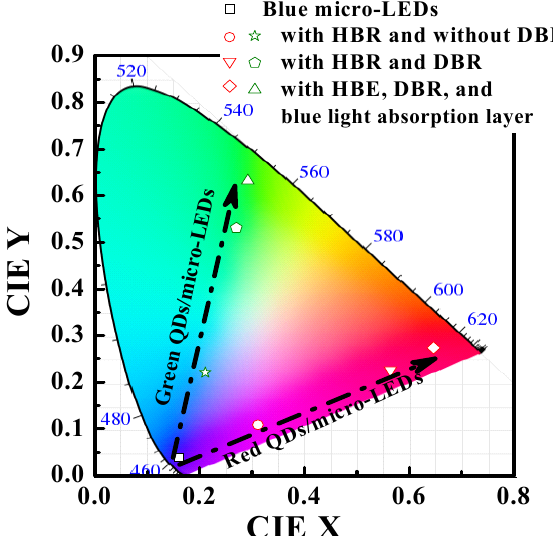
Figure 8. The international commission on illumination (CIE) chromaticity coordinates of the resulting